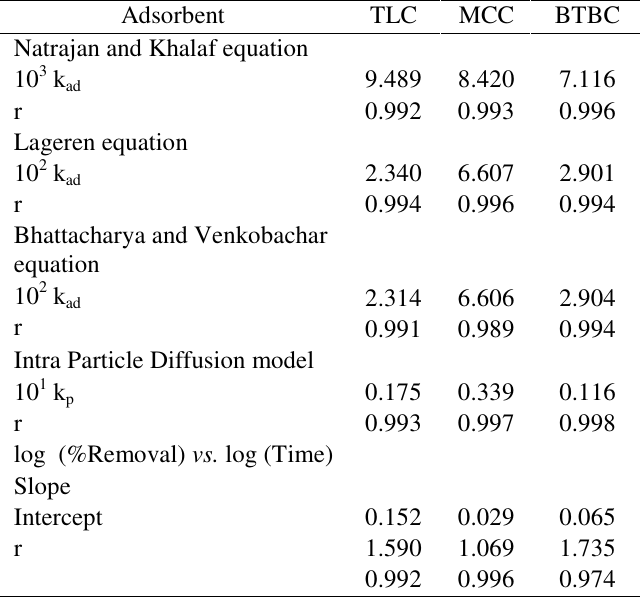
Table 3. Kinetics of adsorption of dye by TLC, MCC and